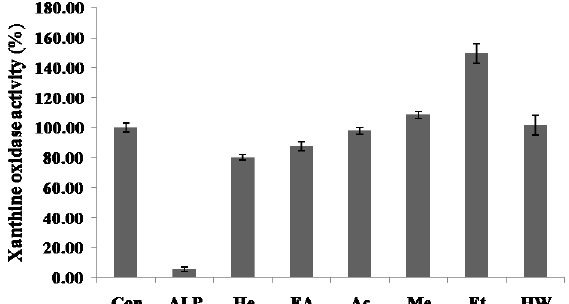
Figure 2. Xanthine oxidase inhibitory activities in various solvent extracts of C.yabunikkei leaves